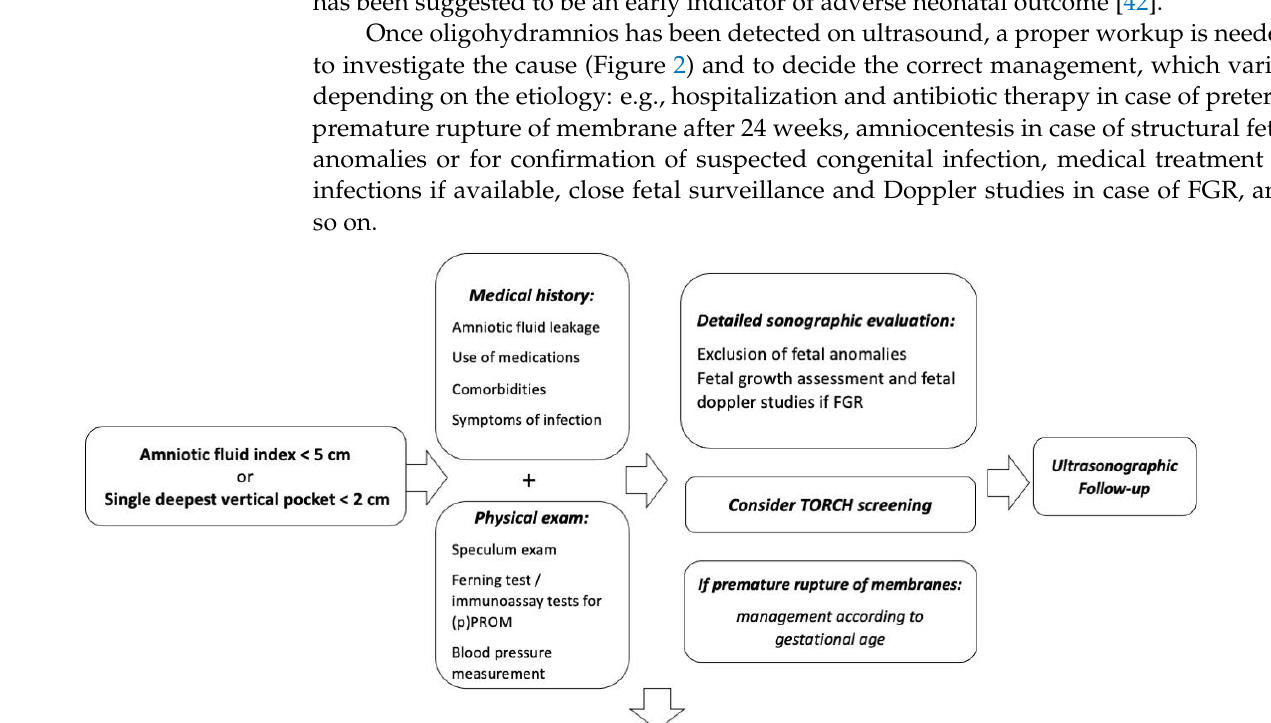
Table 1. Oligohydramnios: etiologies.